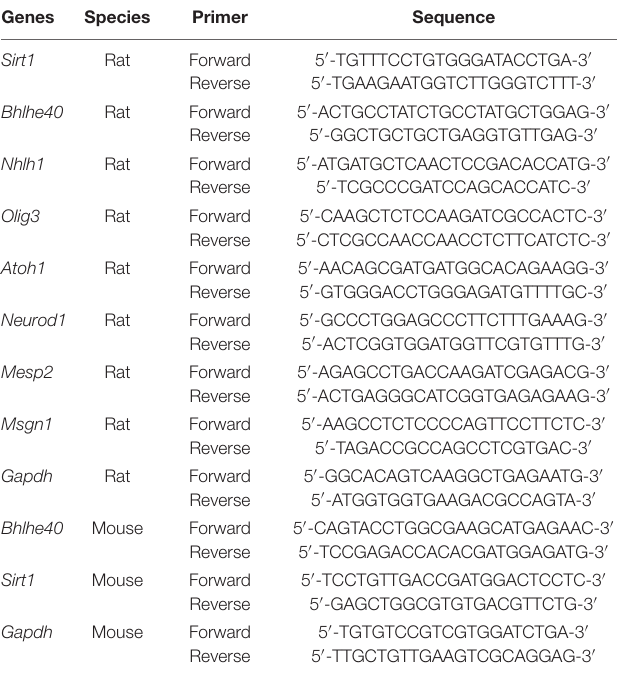
TABLE 1 | Sequences of the primers used for RT-qPCR analysis.